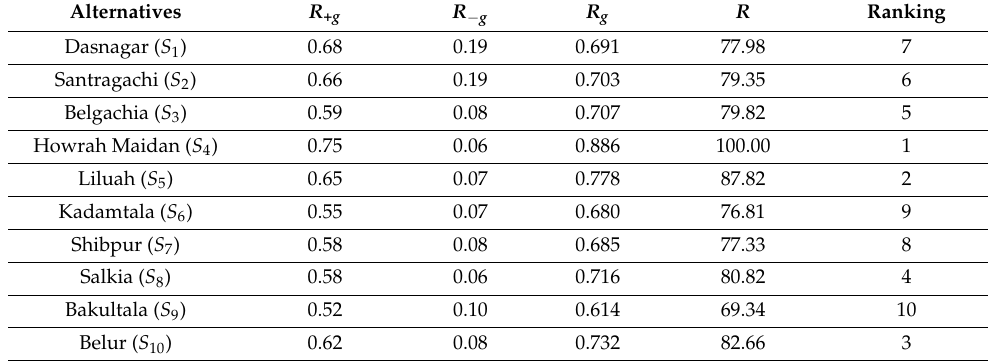
Table 11. Values of R + g , R − g , R g , RR and ranking are